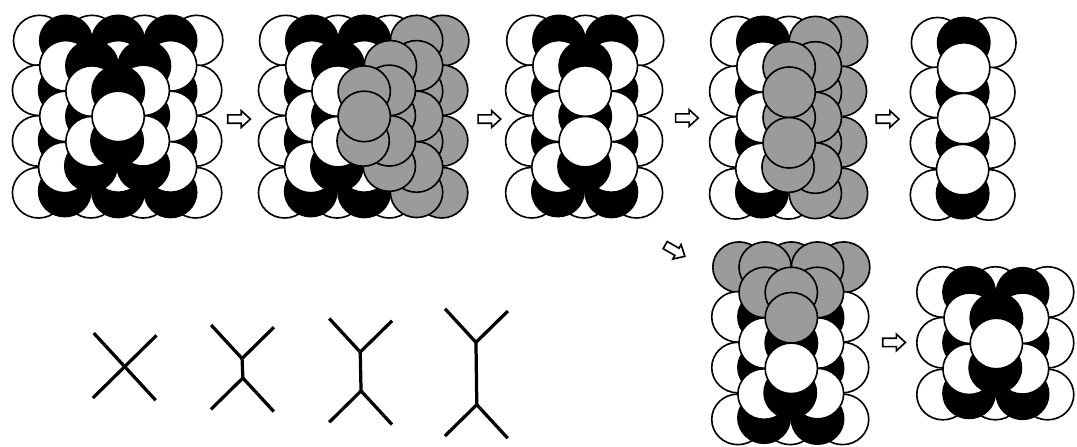
Figure 11 . Peeling off the semi-infinite faces of the conifold crystal. This changes the length of the top row.